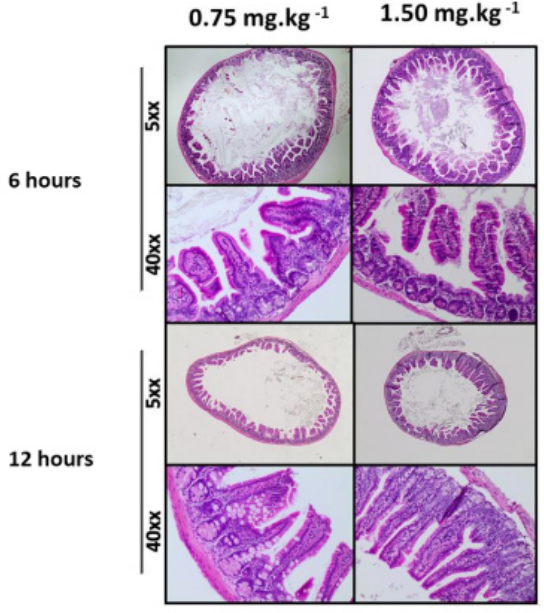
Figure 6. Intestinal histomorphology of BALB/c mice after administration of liriodenine by gavage. Note the absence of pathological changes at different doses (0.75 and 1.50 mg.kg -1 ) of liriodenine and different moments of euthanasia (6 and 12 h of administration) [H&E;